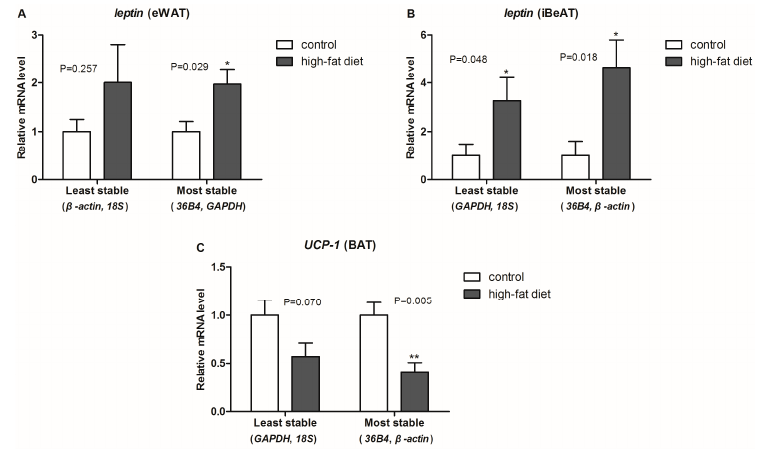
Figure 4. Relative mRNA levels of two target genes in different adipose tissue. (mean ± SEM, n = 6).